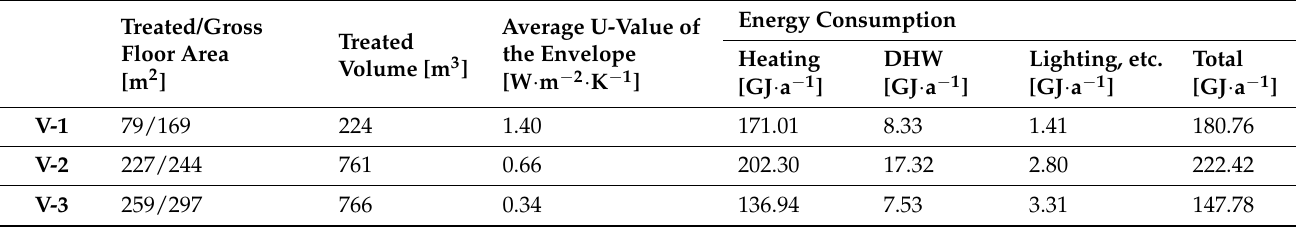
Table 1. Size and energy consumption of the evaluated V1–V3 houses.